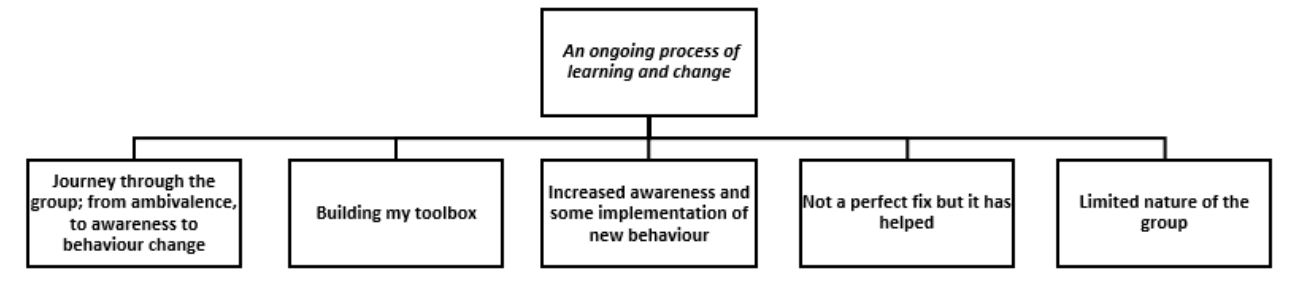
Figure 3. Thematic map. Table 3. Theme presence across